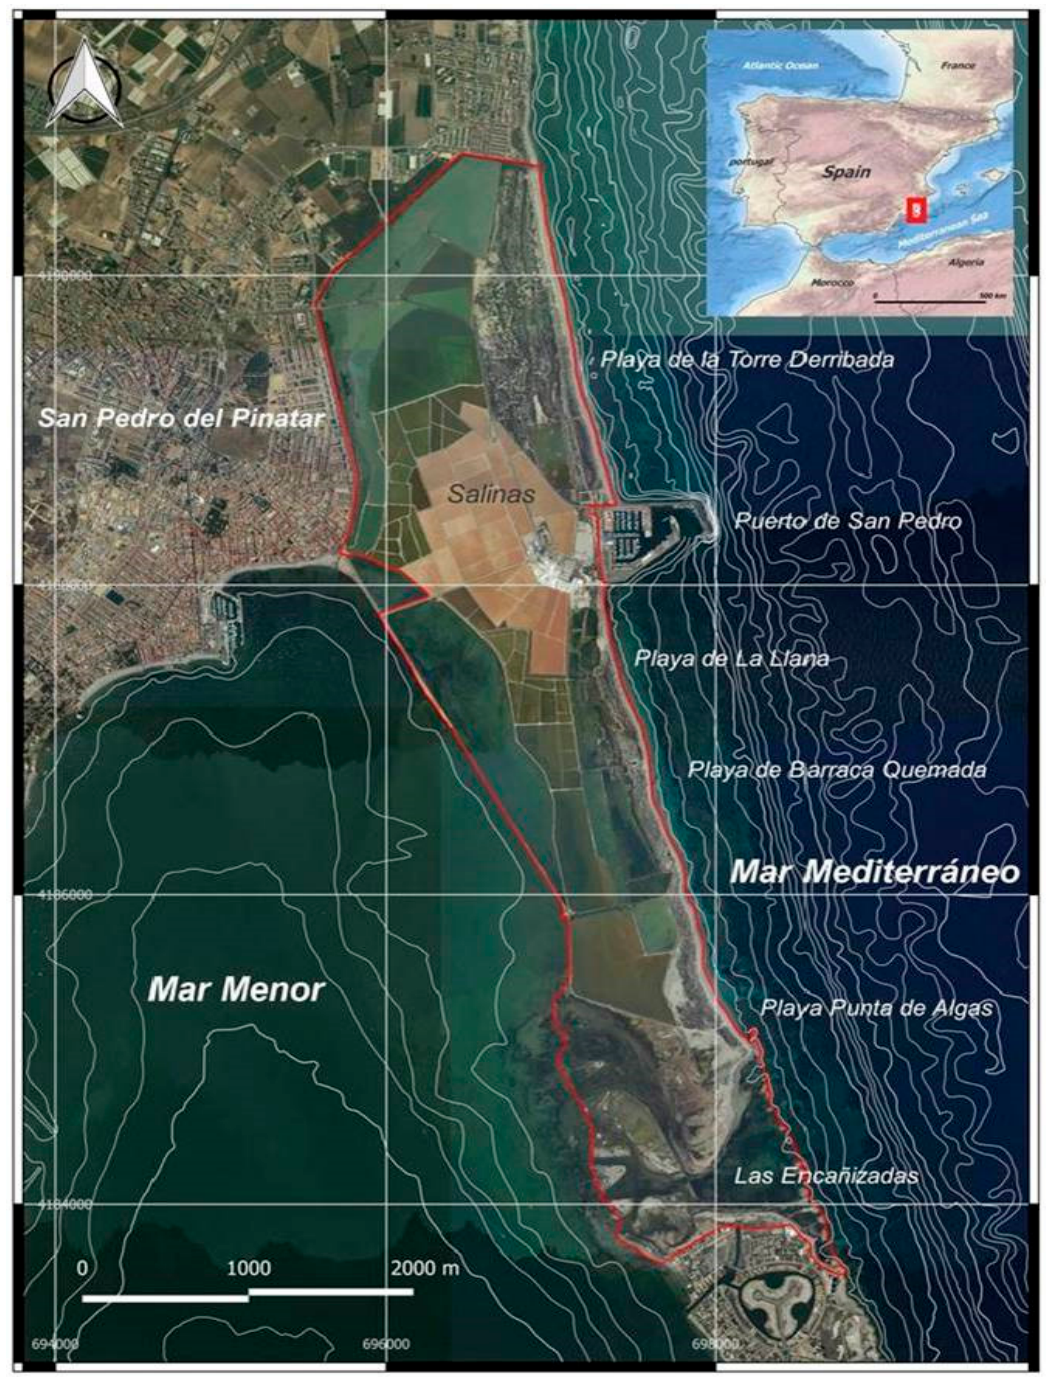
Figure 1. Area of study. Source: own elaboration from a PNOA image.